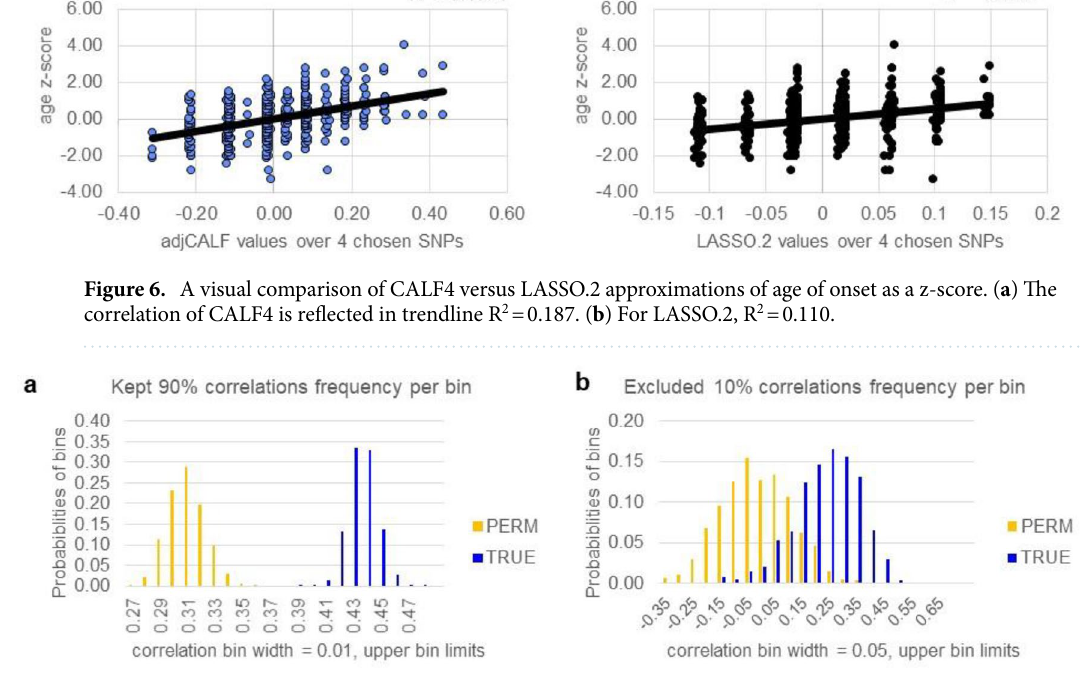
Figure 7. Cross-validation analysis. ( a ) A histogram for cross-validation CALF4 on random 90% kept subsets of SNP data in 1000 trials includes bins of correlation values versus ages of onset. TRUE bars denote values of correlations using 1000 random (with replacement) 90% subsets. PERM bars denote first a random permutation of all 582 ages of onset, then a repetition of the TRUE analysis. Thus, PERM is the null hypothesis result, that is, the absence of information. Welch t-test p-value of the two sets of correlations is ~ 0.00. ( b ) Shown is a histogram of bins of correlation values with ages of onset. TRUE bars denote values of correlations using